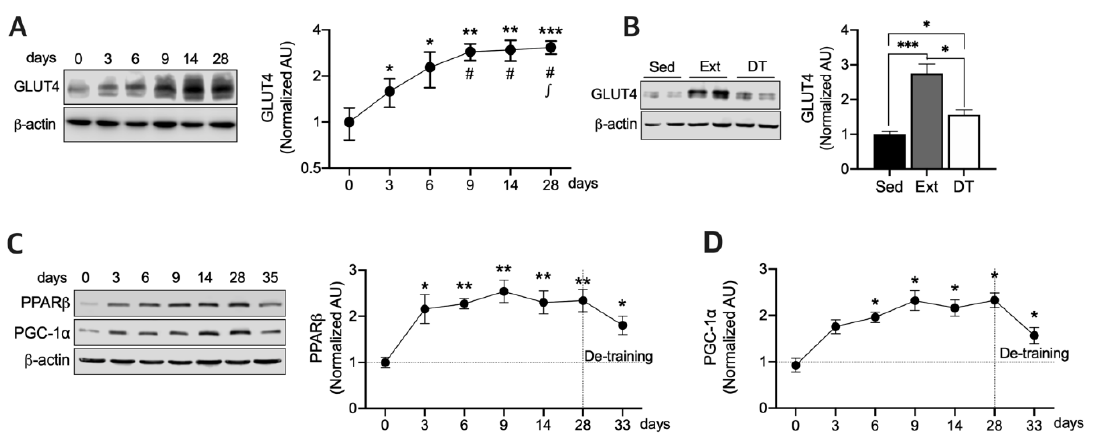
Figure 1. Exercise training (Ext) gradually upregulates glucose transporter type 4 (GLUT4), peroxisome proliferator-activated receptor β / δ (PPAR β ), and peroxisome proliferator-activated receptor gamma coactivator 1-alpha (PGC-1 α ) and increases their stability. ( A ) GLUT4 protein expression was analyzed in a time-dependent manner at 0, 3, 6, 9, 14, and 28 days of exercise training ( n = 6 muscles of rats per group). Values are means ± SE. * p < 0.05, ** p < 0.01, *** p < 0.001 versus day 0. # p < 0.01 versus day 3. ∫ p < 0.05 versus day 6. ( B ) GLUT4 protein expression was analyzed at 28 days of exercise training and after 5 days of de-training (DT) ( n = 6 muscles of rats per group). Sed – Sedentary. Values are means ± SE. * p <0.05, *** p <0.001. ( C , D ). PPARβ and PGC - 1α expression were analyzed in a time-dependent manner at 0, 3, 6, 9, 14, 28 of exercise training and 5 days de-training ( n = 6 muscles of rats per group). Values are means ± SE. * p < 0.05, ** p < 0.01 versus day 0. All muscles were isolated